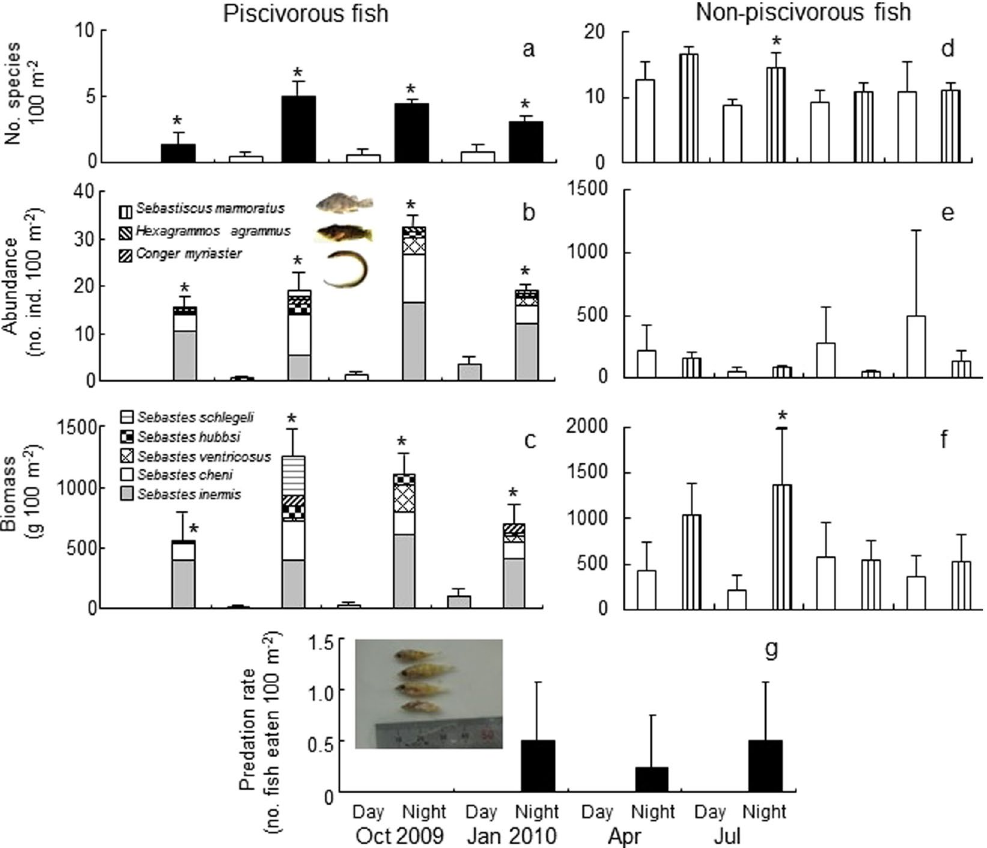
Figure 3. Comparison of the number of species ( a ), abundance ( b ), and biomass ( c ) of piscivorous fishes; the number of species ( d ), abundance ( e ), and biomass ( f ) of non-piscivorous fishes; and the occurrence of fish predation ( g ) between the daytime and nighttime during seasonal sampling from October 2009 to July 2010 in the seagrass bed. Vertical bars represent the standard deviation and the asterisk indicates a significant difference between the daytime and nighttime within the season (Wilcoxon test, p < 0.05). The photograph in the bottom panel shows rockfish ( Sebastes spp.) juveniles found in the stomach of a predator ( Sebastes inermis